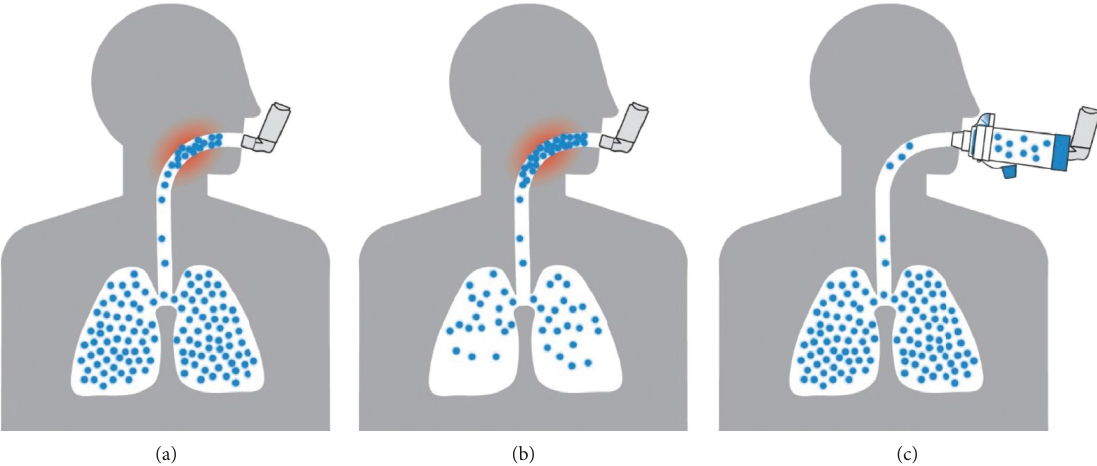
Figure 2: Lung deposition of inhaled medication is improved with perfect pMDI technique and with valved holding chamber. (a) Inhaler alone with perfect technique. (b) Inhaler alone with poor technique. (c) Inhaler with valved holding